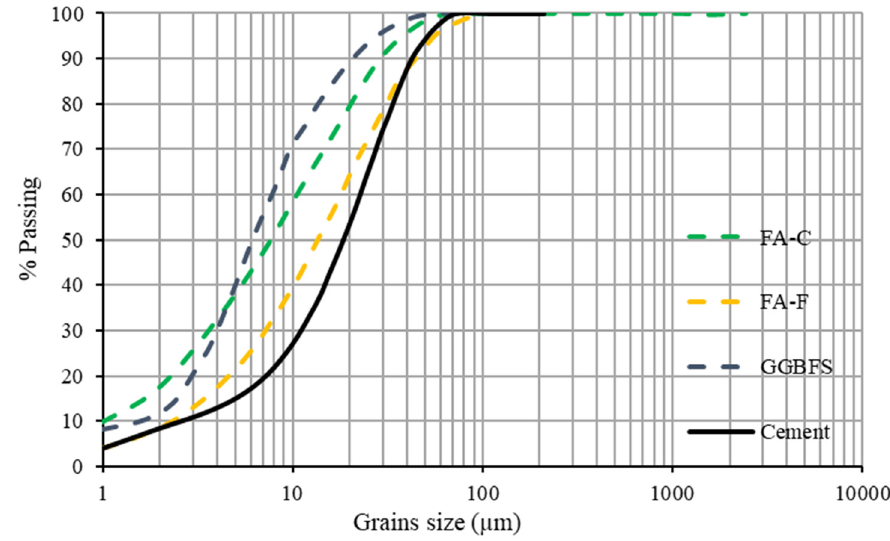
Figure 1. Particle size distribution of supplementary cementitious materials (SCMs) and cement.